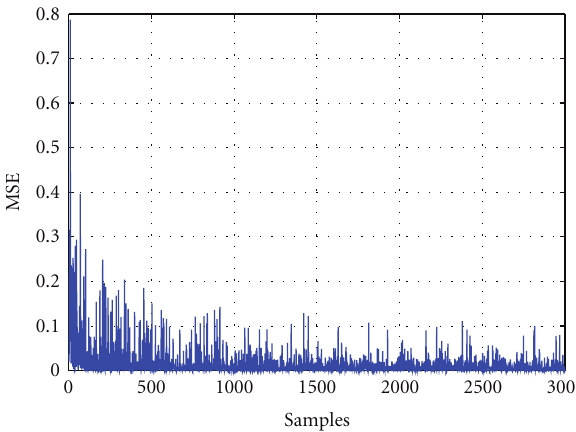
Figure 3: Mean square plot of FLANN based noise prediction model for 3000 iteration.